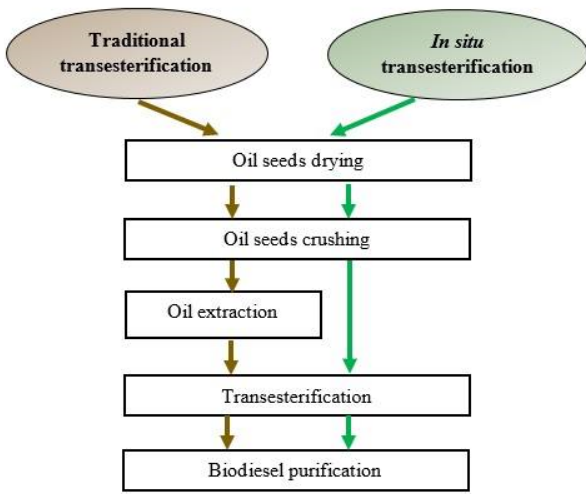
Figure 1. Stages of traditional and “in situ” transesterification.